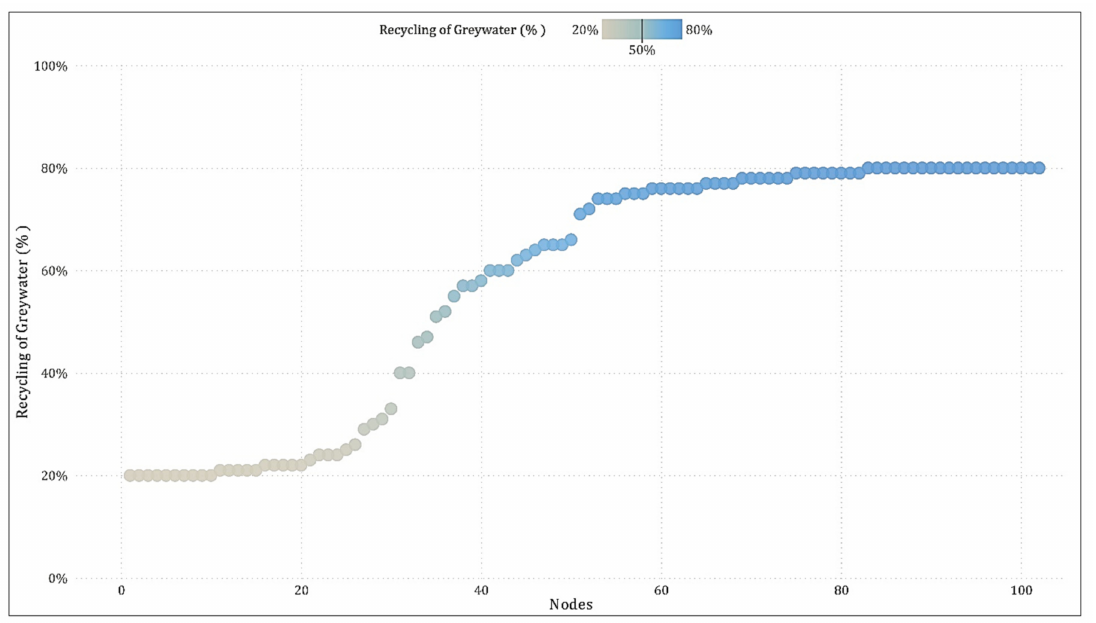
Figure 5. Optimal fractions of graywater treatment at each node: network in Figure 1. Table 3. Cost of graywater reuse implementation for a constant fraction of treatment: network in Figure 1. Uniform Fraction of